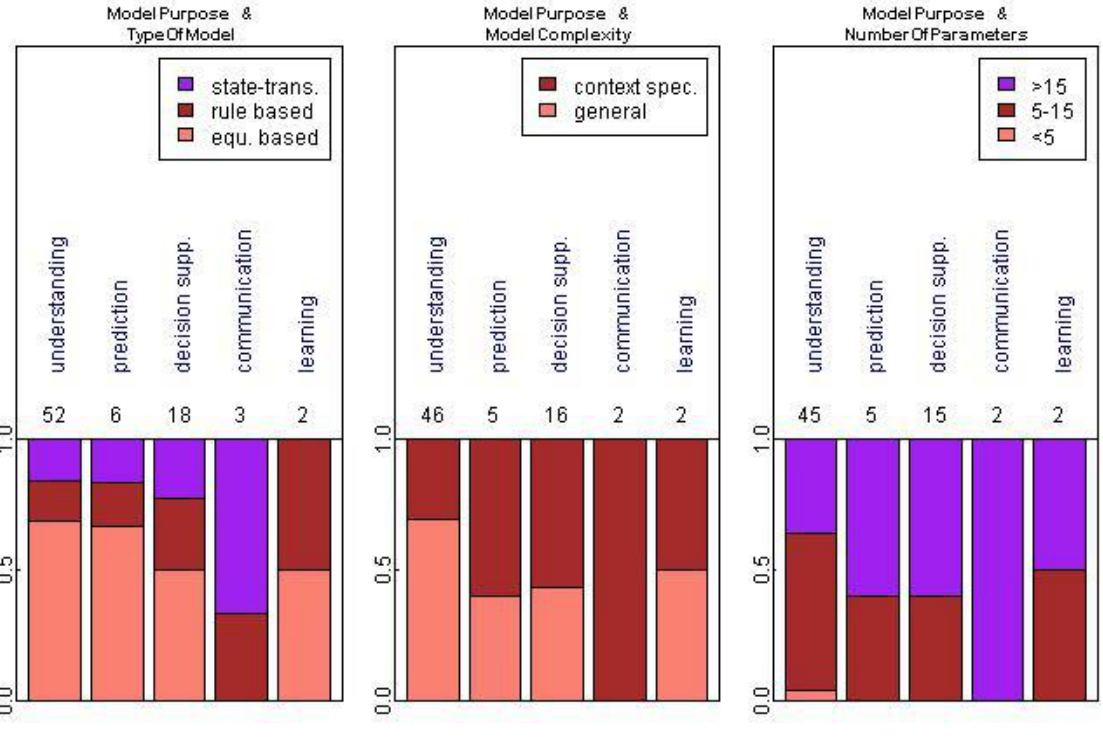
Figure A4: Relationship between model purpose and modeling technique (a) model type, b) model complexity and c) number of parameters